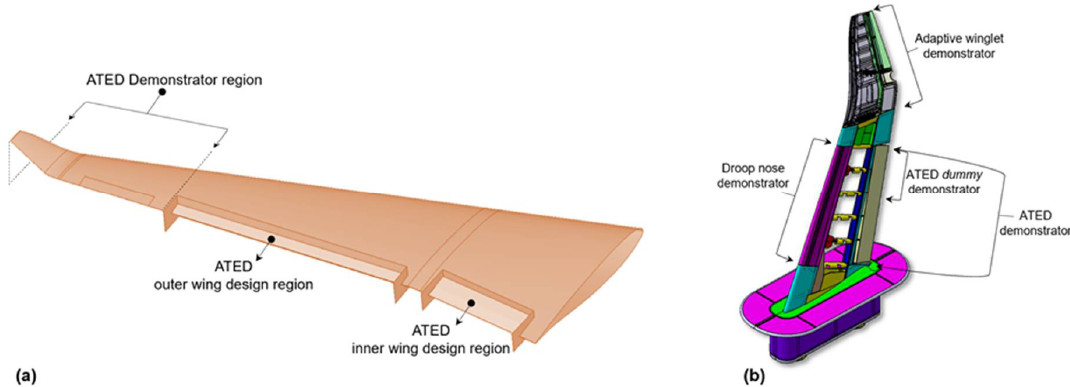
Figure 1. Reference wing ( a ) and technology demonstrator developed within SARISTU ( b ) [18].